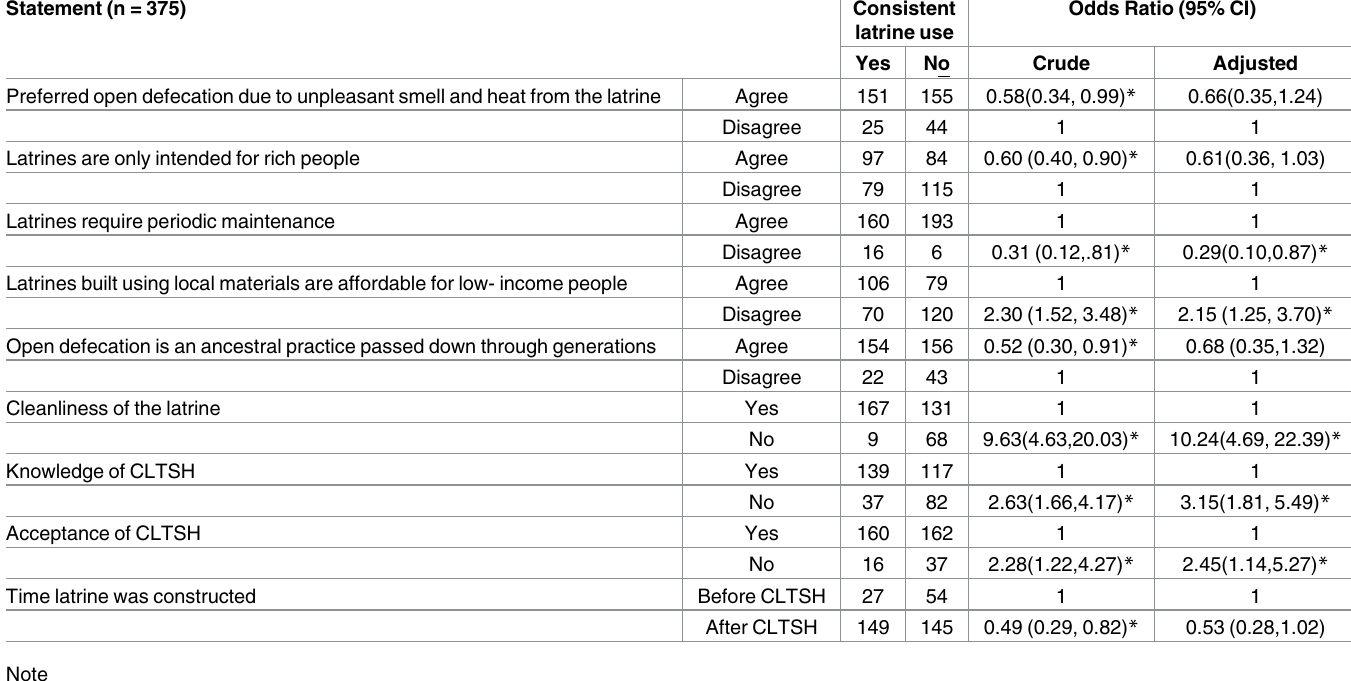
Table 4. Attitude and perception towards CLTSH as measuredby consistent latrine use among study participants in Diretiyara district, Ethiopia,